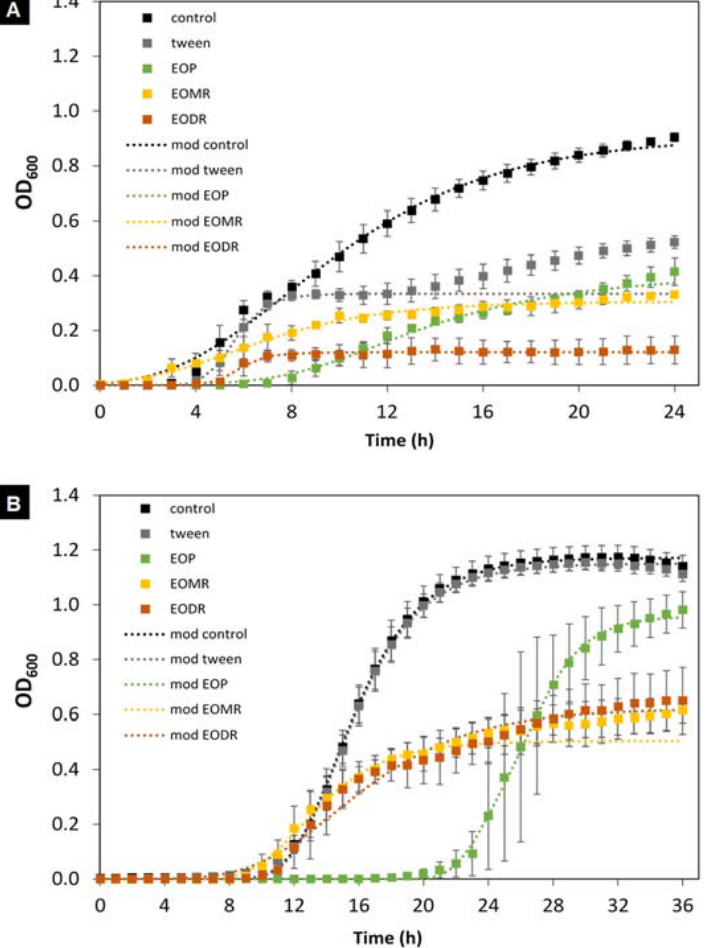
Figure 2. The effects of essential oils from crude organic propolis (EOP) and from its moist residue (EOMR) and dry residue (EODR) on the growth kinetics of E. coli ( A ) and L. plantarum ( B ) at the concentration of 14.8 mg/mL. Dotted curves indicate the experimental data and dashed curves are the adjusted data using the modified Gompertz model. Vertical bars represent the standard devia ‐ tion.